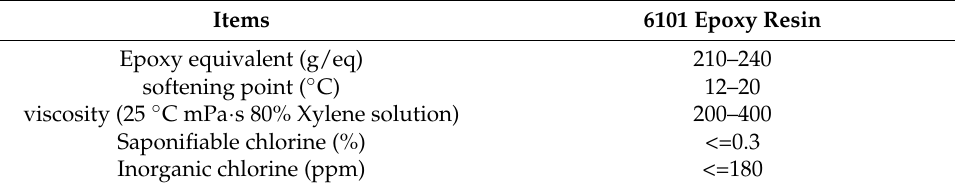
Table 2. The main physical and chemical properties of 6101 epoxy resin.